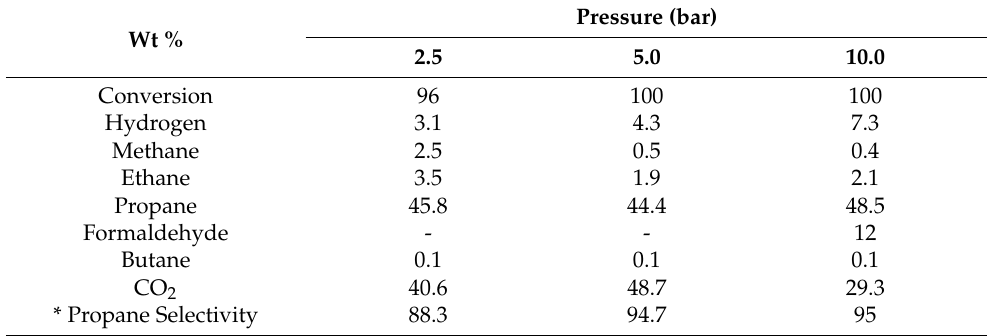
Table 3. Butyric acid conversion and gas yields at 300 ◦ C under different hydrogen